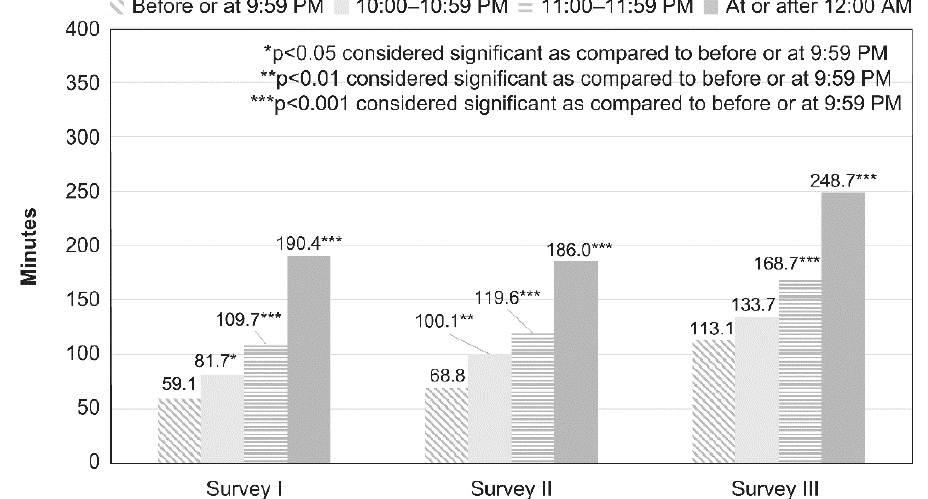
Figure 1. Average daily Internet time (minutes) on weekdays according to bedtime on weekdays in each survey. A comparison of the duration of internet use (in minutes) on weekdays among the groups as per bedtime, as assessed using ANOVA. A post hoc analysis between the group with bedtime before or at 9:59 PM and groups with bedtime at or after 10:00 PM (10:00–10:59 PM, 11:00–11:59 PM and at or after 12:00 PM) was performed using Dunnett’s test.